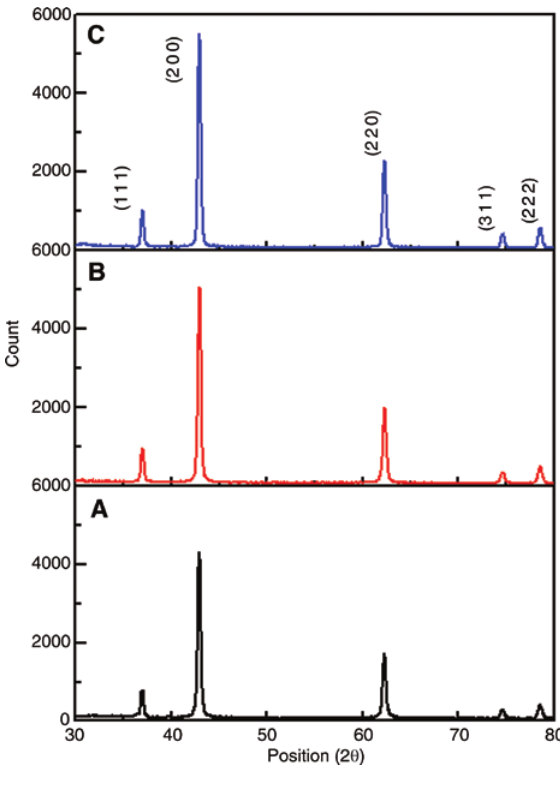
Figure 1: The X-ray diffraction (XRD) patterns of Zn 2 + doped MgO nanoparticles calcinated at: (A) 600 ° C, (B) 700 ° C, and (C) 800 ° C.